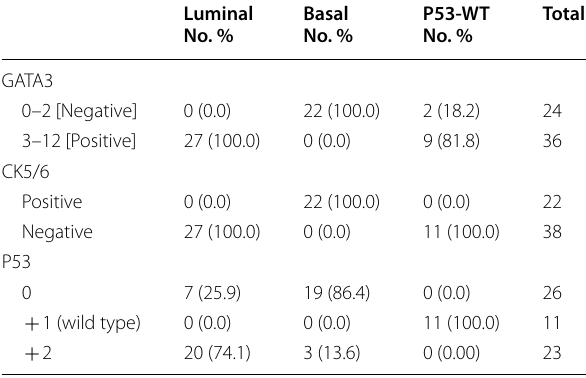
Table 2 Immunoscores of luminal, basal and p53 markers in